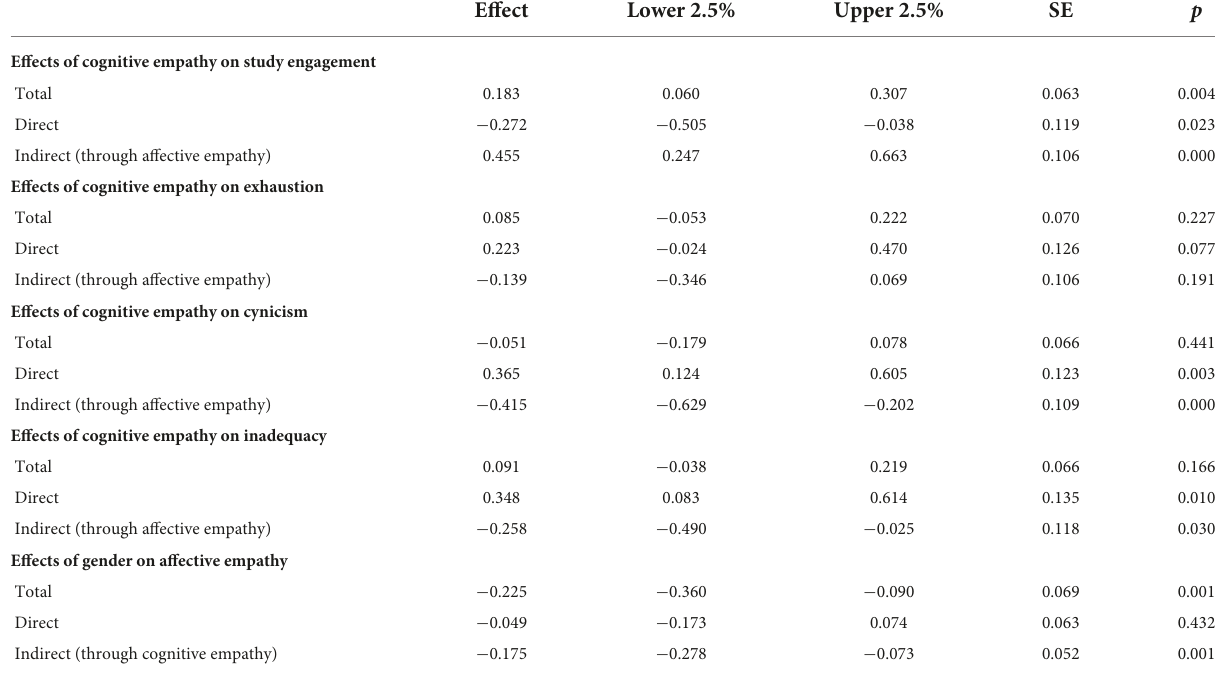
TABLE 2 Standardized indirect estimates, confidence intervals, and p